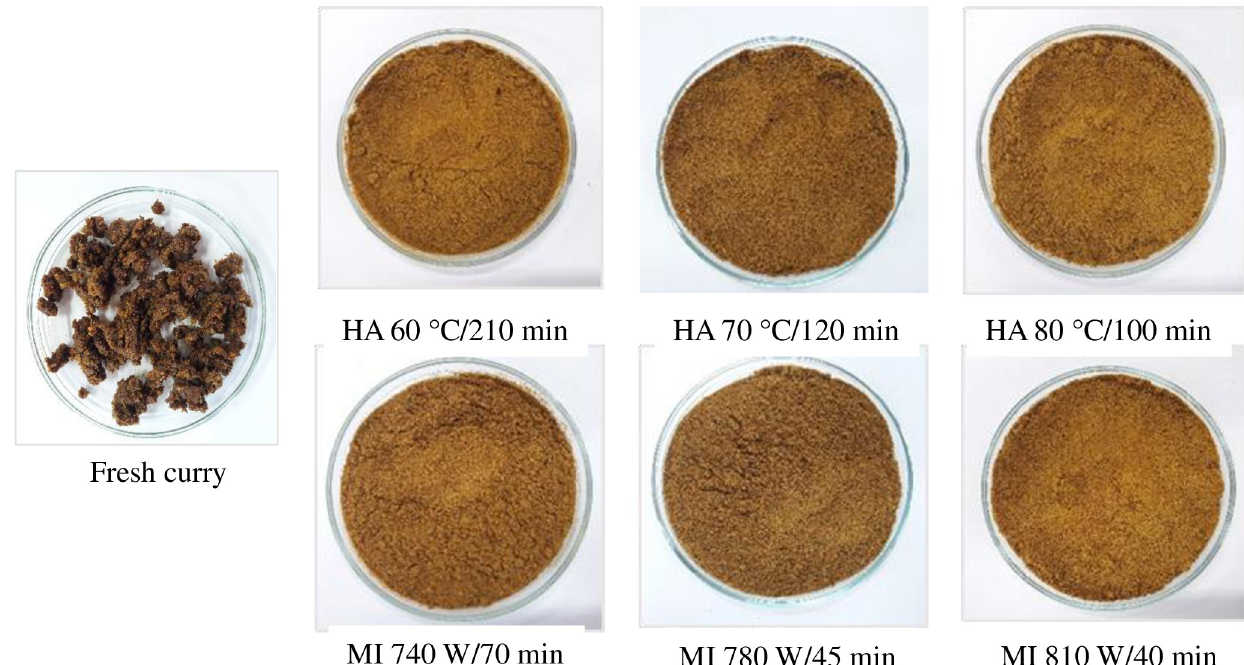
Fig 5. Appearances of Tai-Pla curry paste (fresh sample) and Tai-Pla curry powder (TCP) dried using hot air (HA) and hybrid microwave-infrared drying (MI) under different drying conditions.